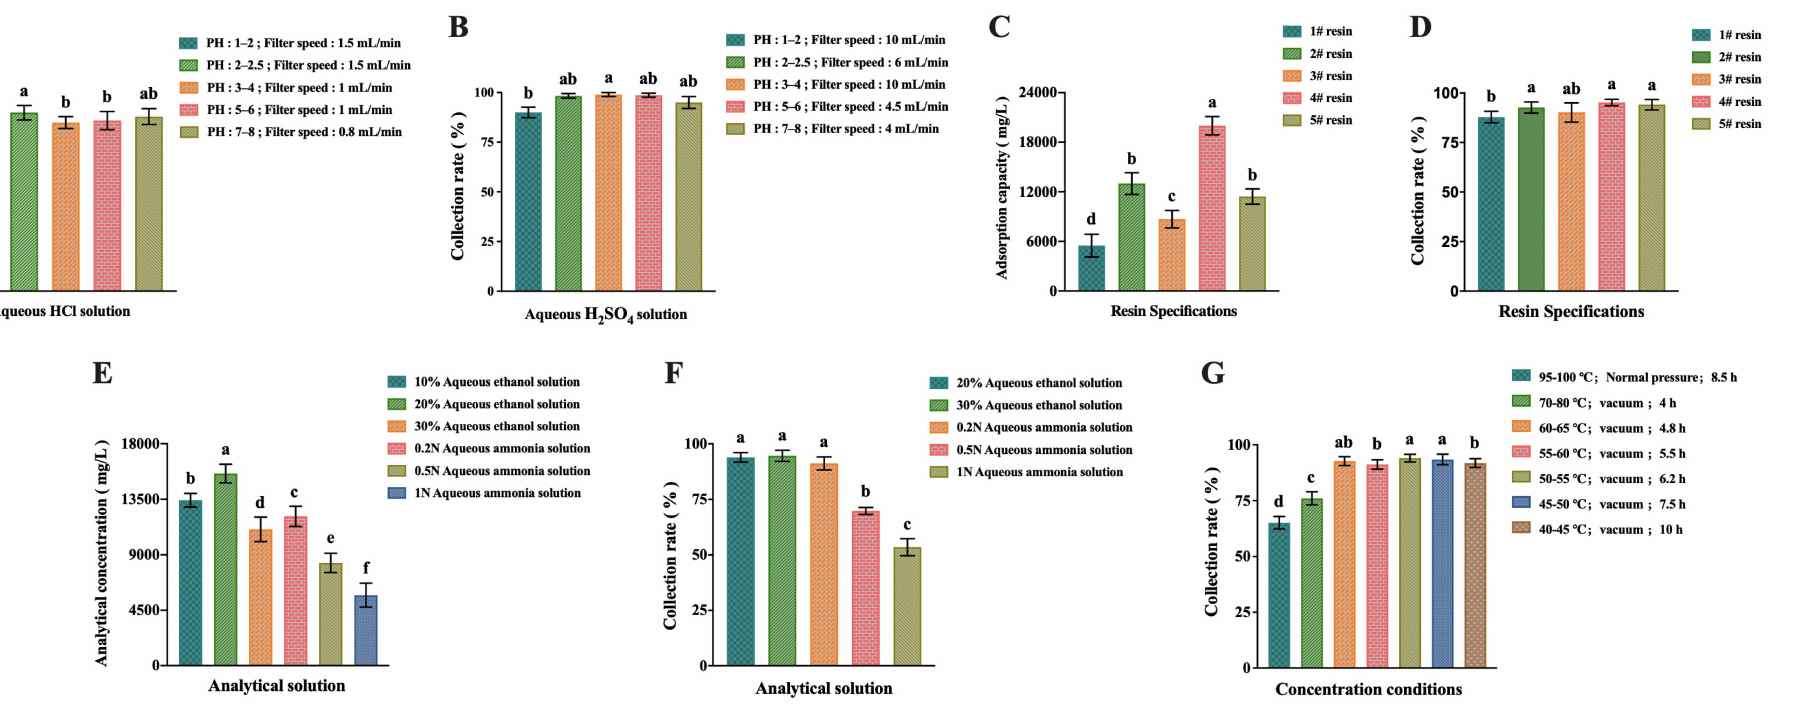
Figure 3. Results of separation process optimization. ( A ) Pretreatment with aqueous hydrochloric acid; ( B ) pretreatment with aqueous sulfuric acid; ( C ) adsorption capacity using different specifications of resin; ( D ) collection rates using different grades of resin; ( E ) concentrations of different analytical solutions; ( F ) collection rates using different analyte solutions; (G ) collection rates using different concentration temperatures. The data are shown as means ± SD of three independent experiments. Lowercase letters indicate significant differences ( p < 0.05) between any two